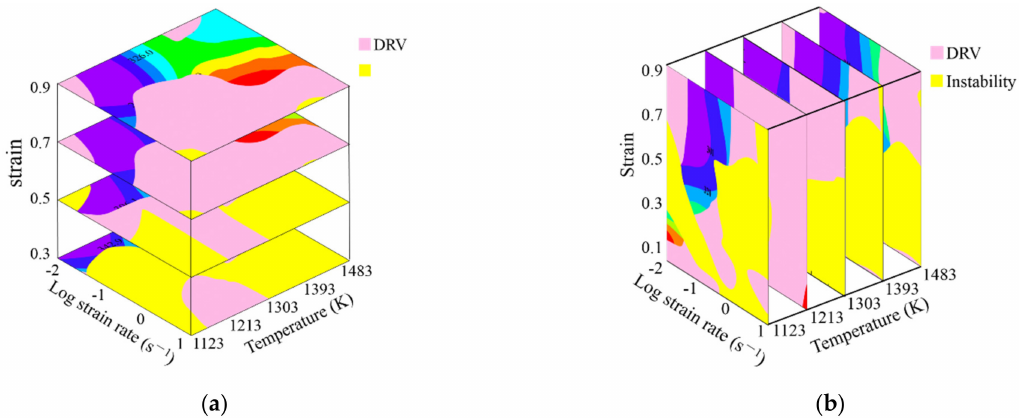
Figure 17. Enhanced deformation mechanism map of SAE 5137H steel: ( a ) strain section; ( b ) temper- ature